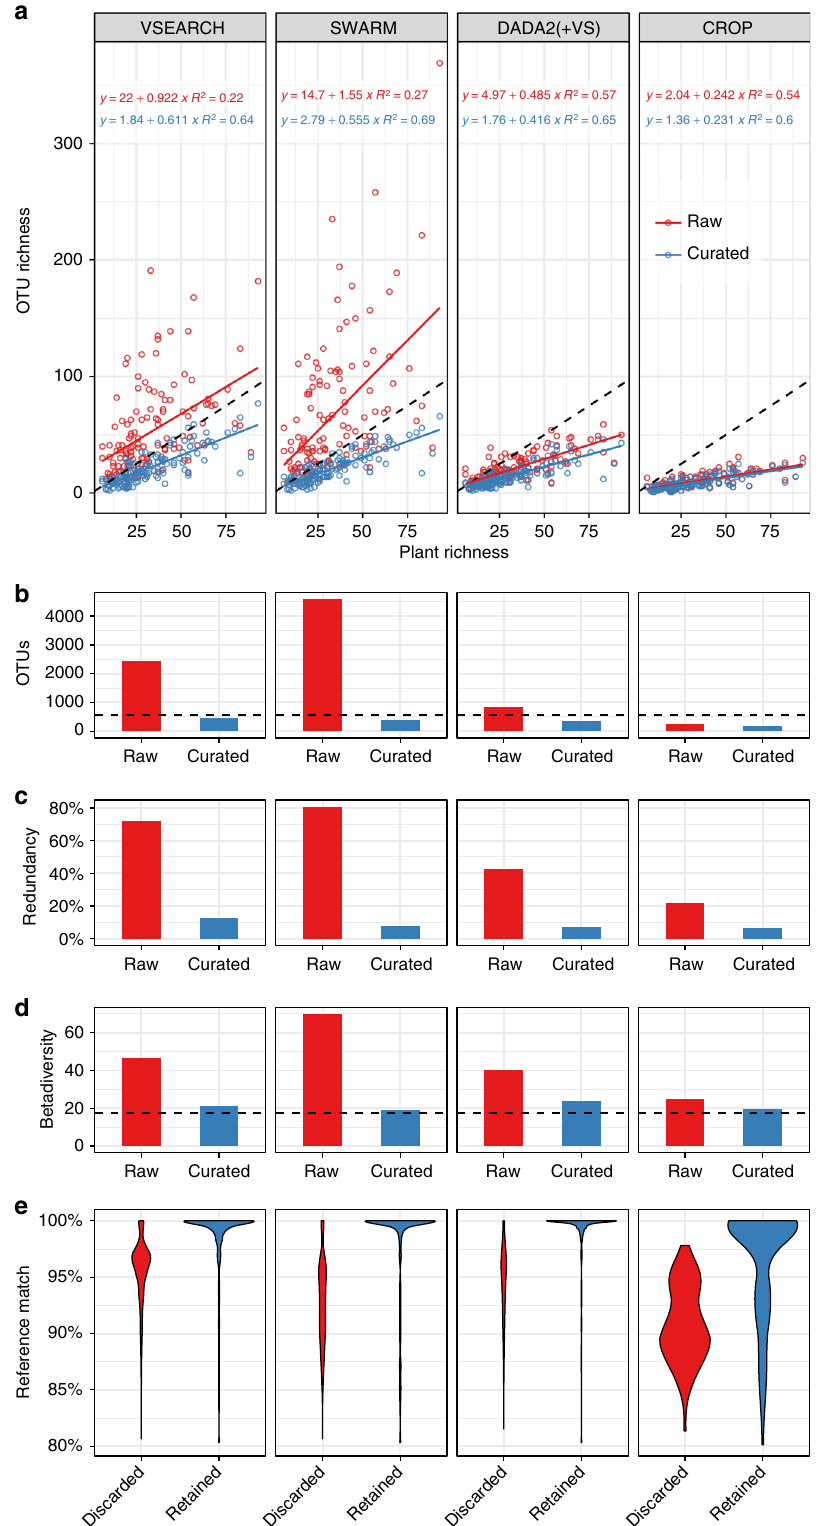
Fig. 1 Effects of curation with the LULU algorithm for clustering methods at 97% level. OTU table metrics before (red = raw) and after (blue = curated) curation with LULU. a correspondence of OTU (plant ITS2 sequence data) richness vs. plant richness for each of the 130 sampling sites, b total number of OTUs compared to total plant species recorded (564 species, dashed line), c percentage of OTUs having taxonomically redundant annotation, d OTU β -diversity (total richness/mean site richness) compared to plant β -diversity (17.23, dashed line), e distribution of best reference database (GenBank) match for OTUs retained and discarded by